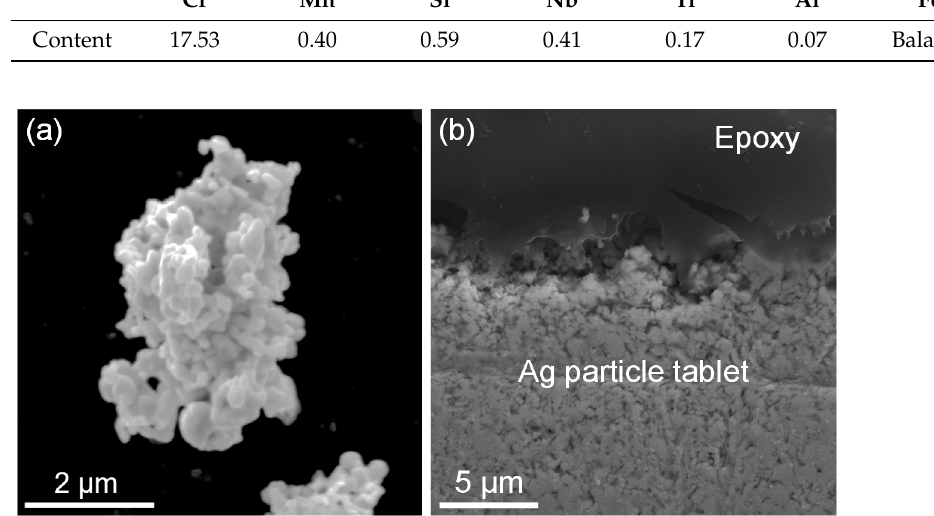
Figure 1. ( a ) Morphology of the Ag powder and ( b ) morphology of the Ag particle tablets. Table 1. Composition of the AISI 441 stainless steel (wt.%).